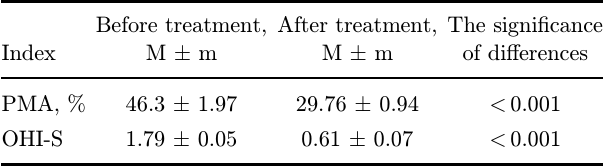
Table 3. Values of the dental indices in the ¯rst group before and after treatment ( n ¼ 30).